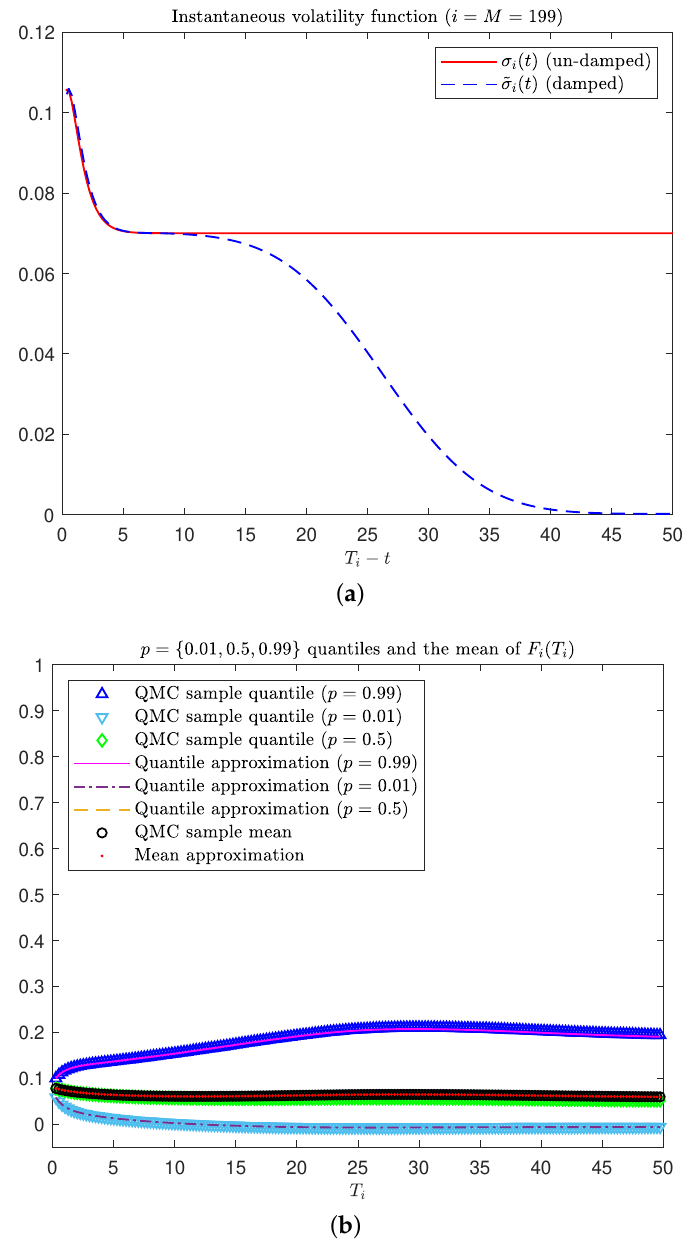
Figure 5. Diagnostic tool for analysing the distribution of the long-dated forward LIBORs in the five- factor DLFM scenario using the damped instantaneous volatility function in (36). ( a ) Comparison of the un-damped (23) and damped (36) instantaneous volatility functions. ( b ) Comparing the realised forward LIBOR p = { 0.01,0.5, 0.99 } quantiles and mean approximations to their benchmark QMC sample estimates (on the same scale as Figure